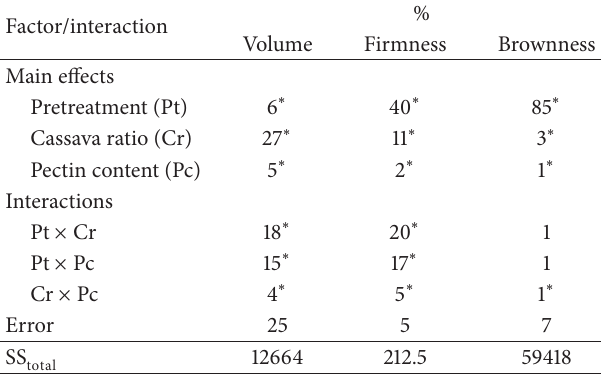
Table 2: Direct and interaction effect of bread quality parameters. % Factor/interaction Volume